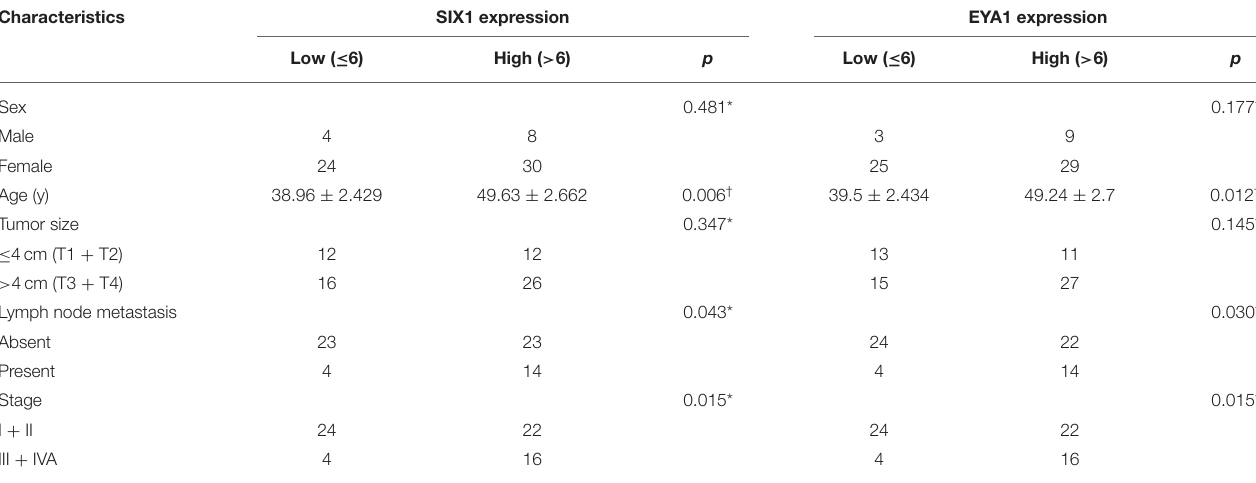
TABLE 1 | Association between SIX1/EYA1 expression and clinicopathologic factors in papillary carcinoma (TH8010 + TH802a).